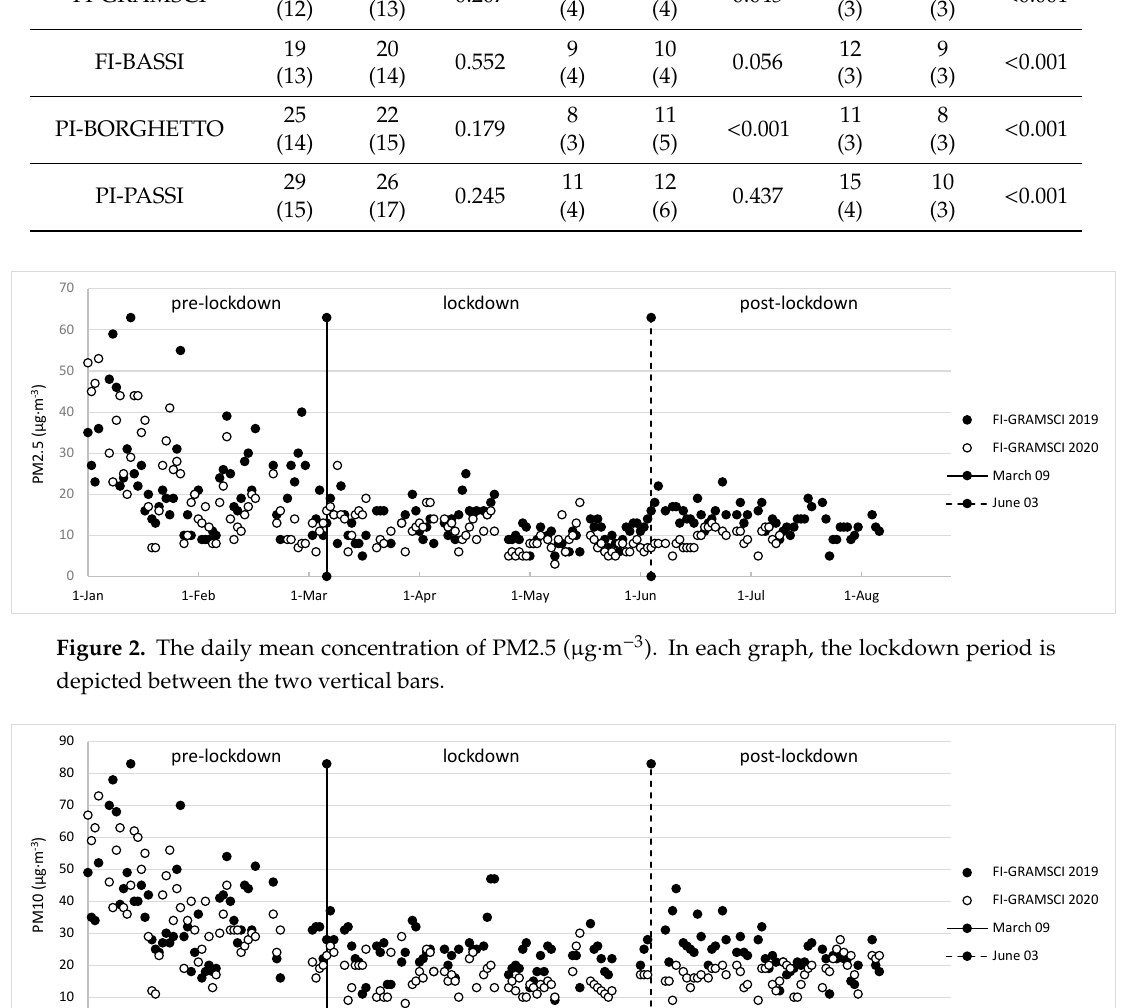
Figure 2. The daily mean concentration of PM10 ( μ g ∙ m − 3 ). In each graph, the lockdown period is Figure 3. The daily mean concentration of PM10 ( µ g · m − 3 ). In each graph, the lockdown period is depicted between the two vertical bars. depicted between the two vertical